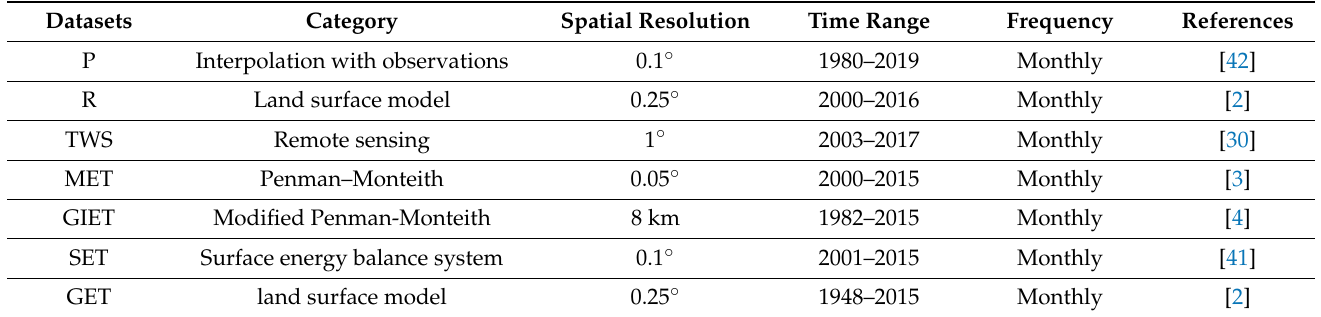
Table 2. Overview of the datasets.